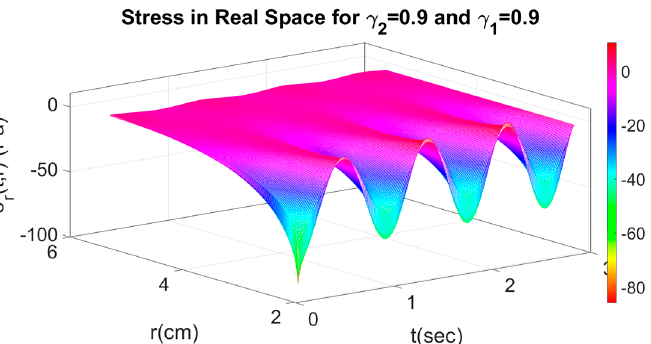
Figure 12. Distribution of the radial stress σ r ( t , r ) in the initial space with space (porosity) fractional order γ 1 = 0.9 and time fractional order γ 2 = 0.9.